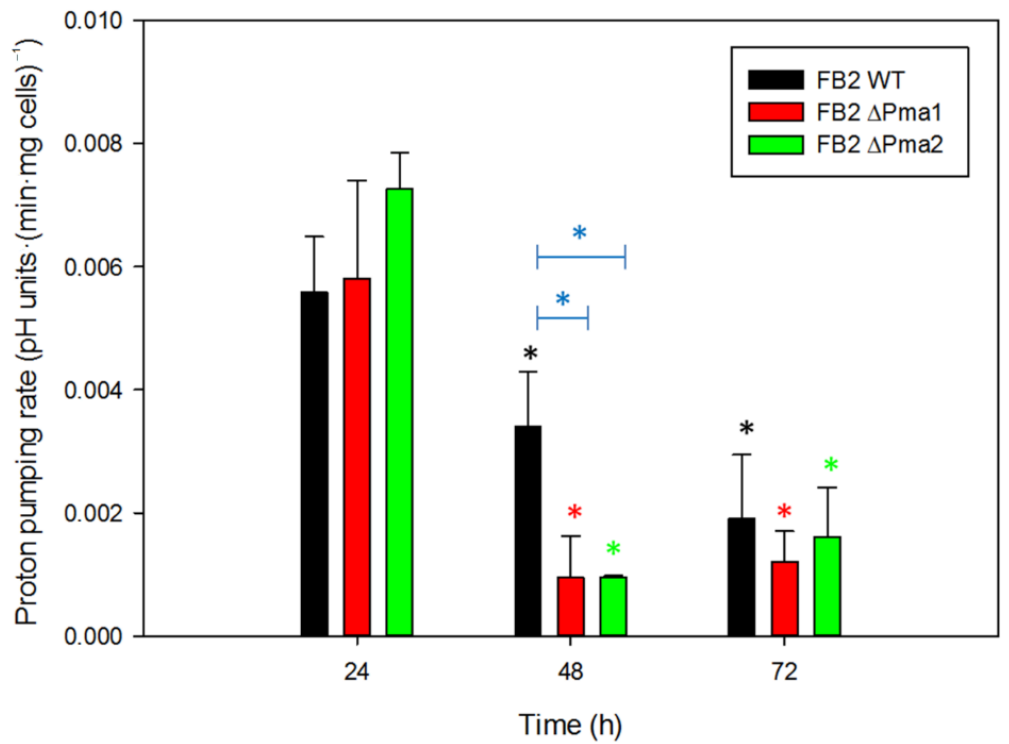
Figure 3. Ustilago maydis proton pumping rate. U. maydis wild-type and mutant strains were cultured in YPD media, and cells were collected at 24, 48, and 72 h to measure the acidification of the external medium. Proton pumping activity is expressed as pH units · (min · 10 9 cells) − 1 . One-way ANOVA analysis was performed and a statistically significant difference ( p < 0.05) was found between times (black, red, and green asterisks) and between wild-type and mutant strains at 48 h (blue asterisks) (n ≥ 3). Bars indicate standard deviation.